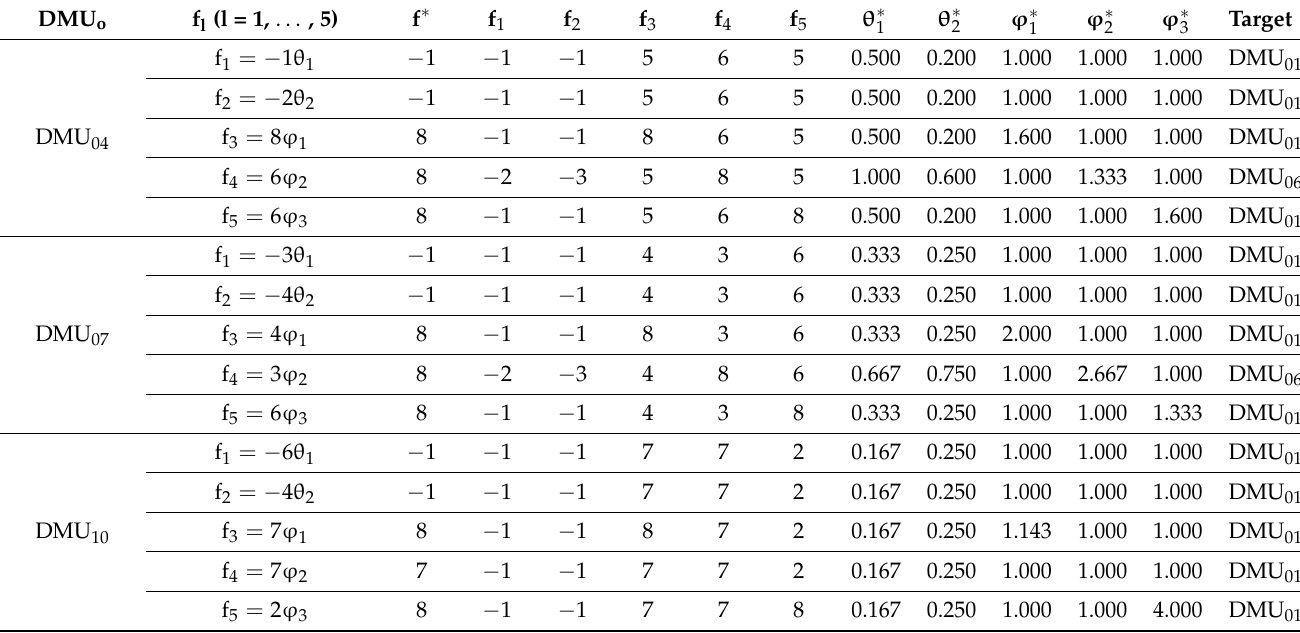
Table A2. The results of solving model 13 for three DMUs (related to the second interactive stage) in the second case study. DMU o f l (l = 1, . . . , 5)